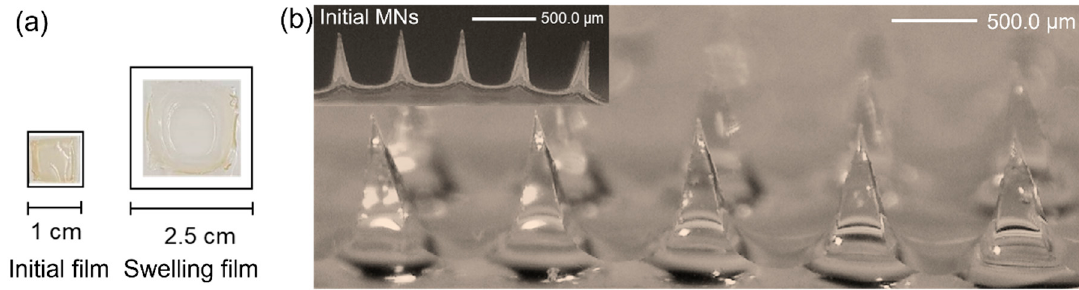
Figure 3. The dry and swelling forms in the artificial ISF for 5 min of ( a ) hydrogel films and ( b ) hydrogel-forming MNs.